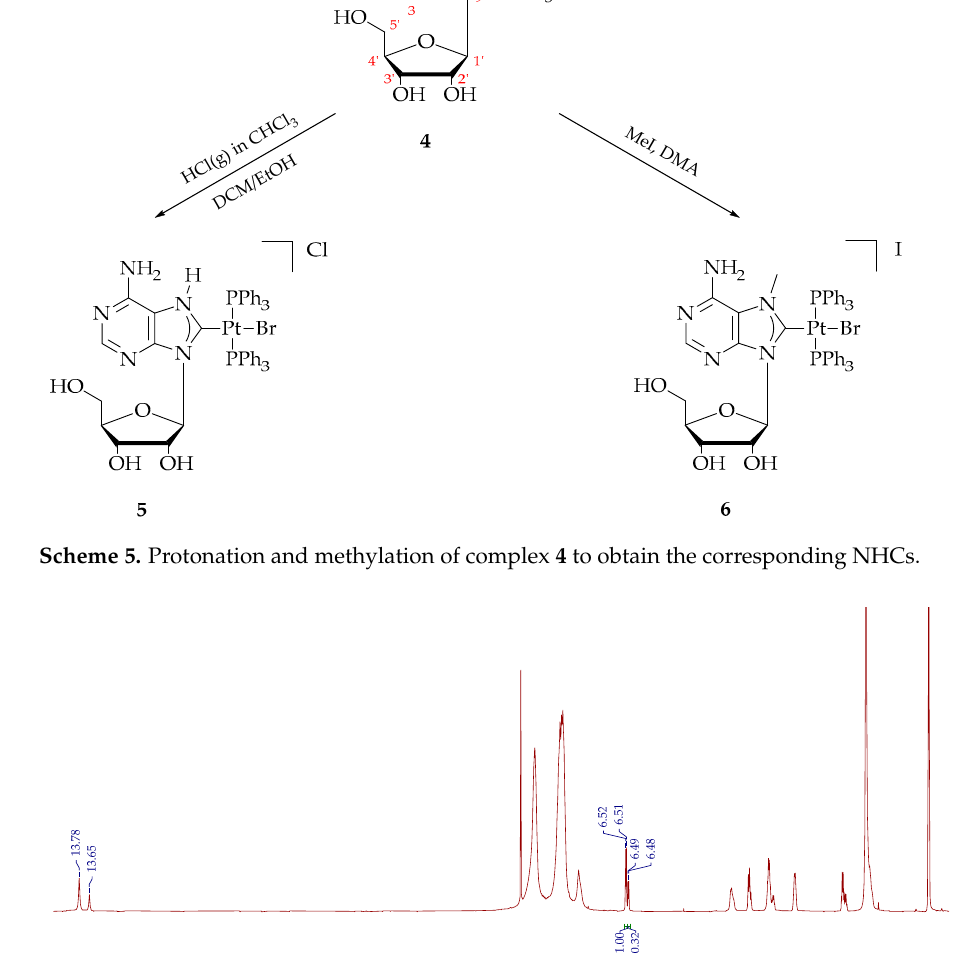
Figure 1. 1 H NMR spectrum of complex 5 in DMSO- d 6 at room temperature, after 6 days in solution.